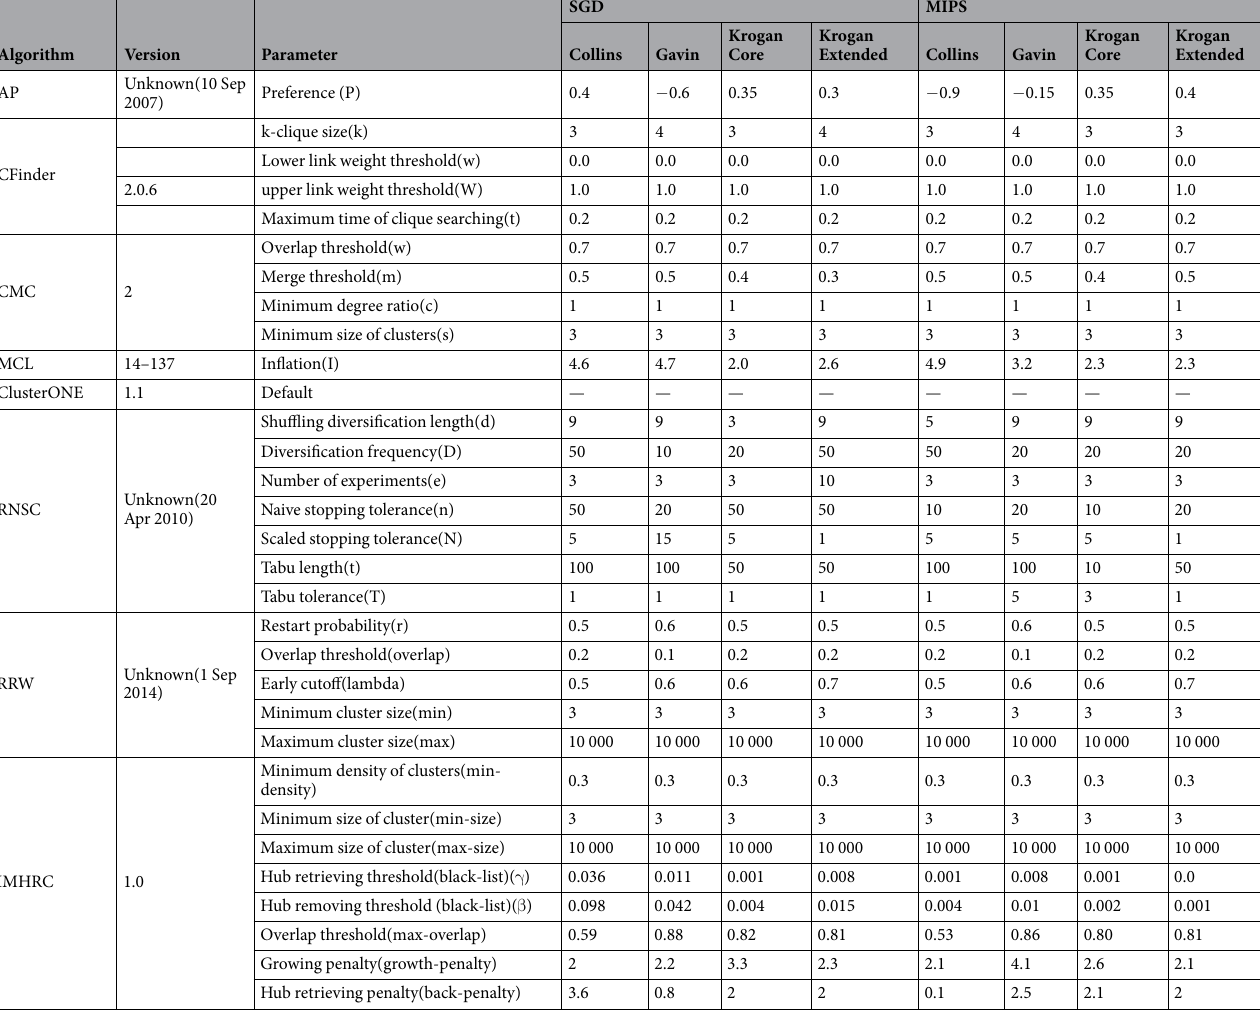
Table 3. The applied clustering algorithms’ settings in different